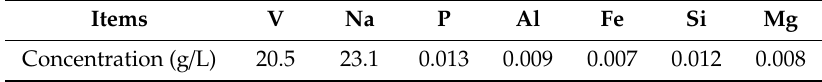
Table 1. Concentrations of the main elements in the alkaline-stripped pentavalent vanadium solution (ASPVS).